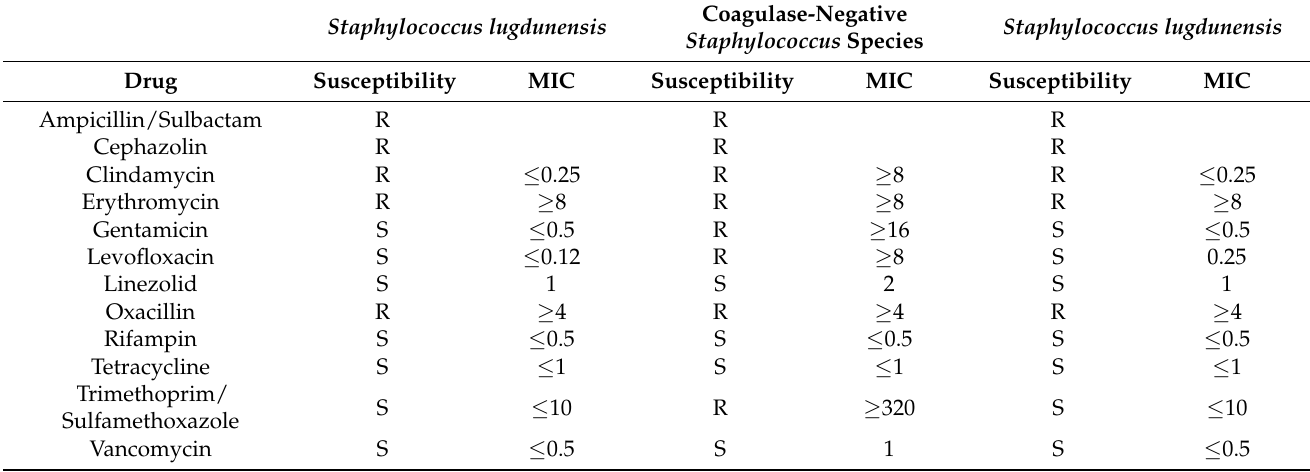
Table 2. Antibiogram of the bacteria isolated from the patient.